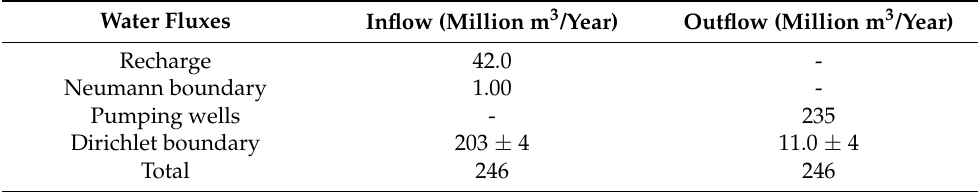
Table 2. Water balance for the Qatar aquifer based on the 90 calibrated